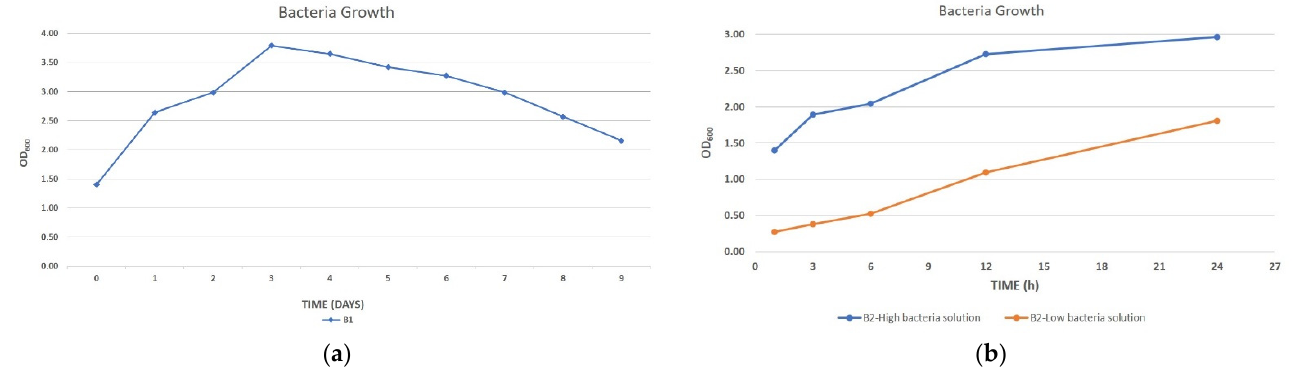
Figure 2. Bacterial growth curves using Optical Density value 600 nm (OD 600 ). ( a ) For experiment 1, the bacteria B1 was monitored for 9 days. ( b ) For experiments 2 and 3, the bacteria B2 was monitored for 24 h.